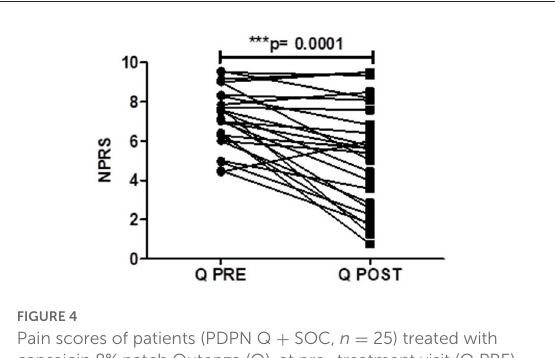
FIGURE4 Pain scores of patients (PDPN Q + SOC, n = 25) treated with capsaicin 8% patch Qutenza (Q), at pre–treatment visit (Q PRE) and 3 months after treatment (Q POST), on Numerical Pain Rating Scale (NPRS). Statistically significant difference at 3 months after treatment (*** p = 0.0001; n = 25; paired t